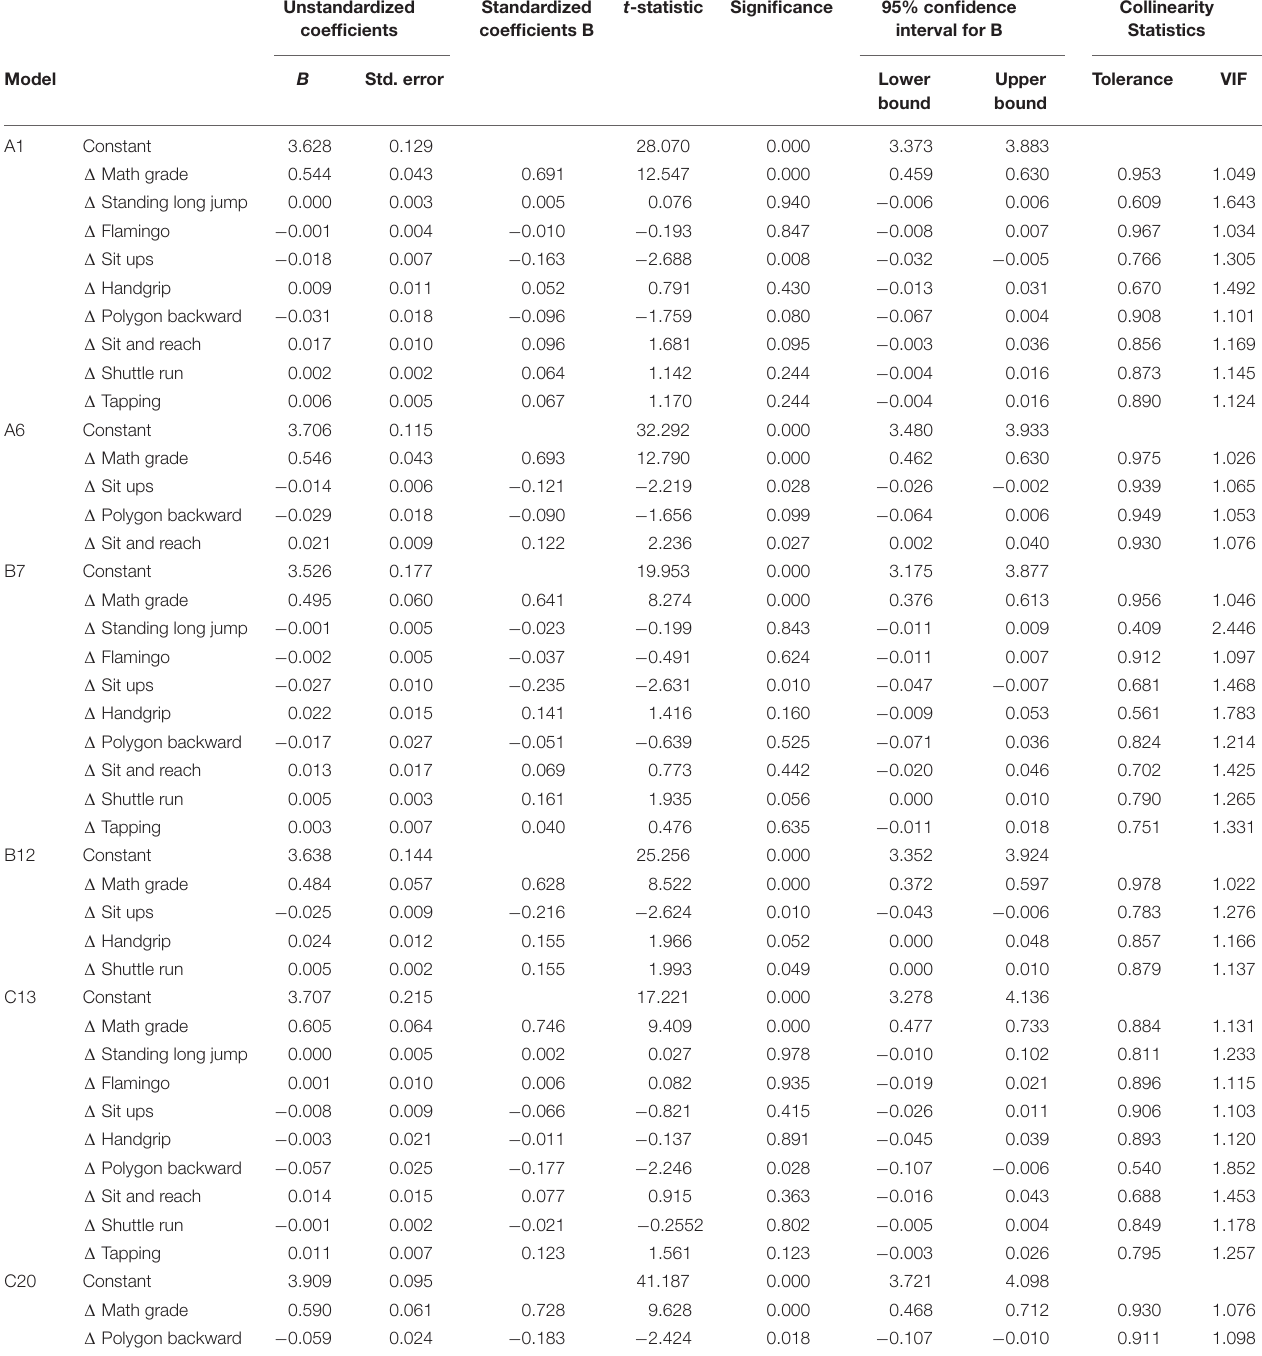
TABLE 4 | Coefficients data for the first and final model for (A) entire sample ( N = 184), (B) boys ( N = 100), and (C) girls ( N = 84),